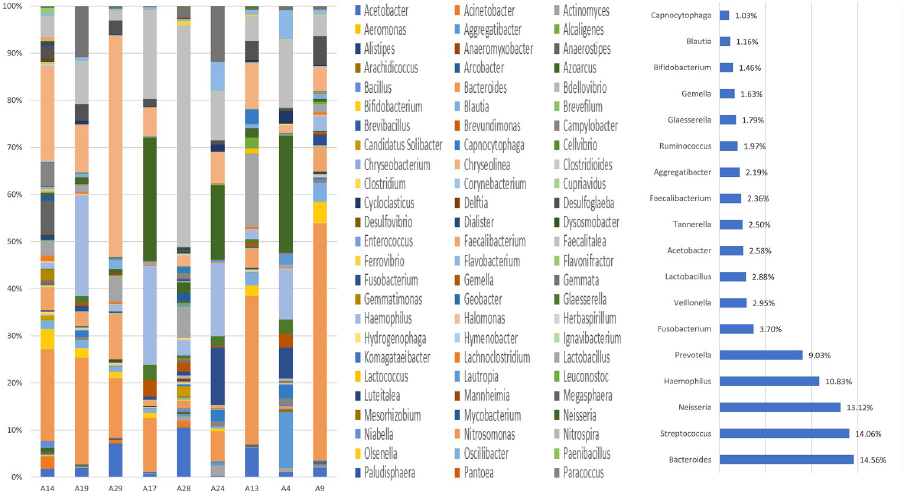
Fig 2. a. Genus-level oral microbiome composition of Betel quid Non-Chewers: 102 genera including Bacteroides (14.56%), Streptococcus (14%), Neisseria (13%), Haemophilus (10%), and Prevotella (9%); b . The abundant genera detected in the Betel quid non-chewer individuals (excluding genera with less than 1% of relative abundance). https://doi.org/10.1371/journal.pone.0278221.g002 the highest abundant species observed were Streptococcus mutans (16%), Neisseria animalis (13%), Haemophilus parainfluenzae (11%), Fusobacterium nucleatum , and Bacteroides dorei (6%). Three Streptococcus species were identified including Streptococcus mutans , Streptococcus pneumoniae , and Streptococcus salivarius . The abundance variance pattern was observed for Streptococcus species ranging from 0.004% for Streptococcus salivarius to 16% for Streptococcus mutans .